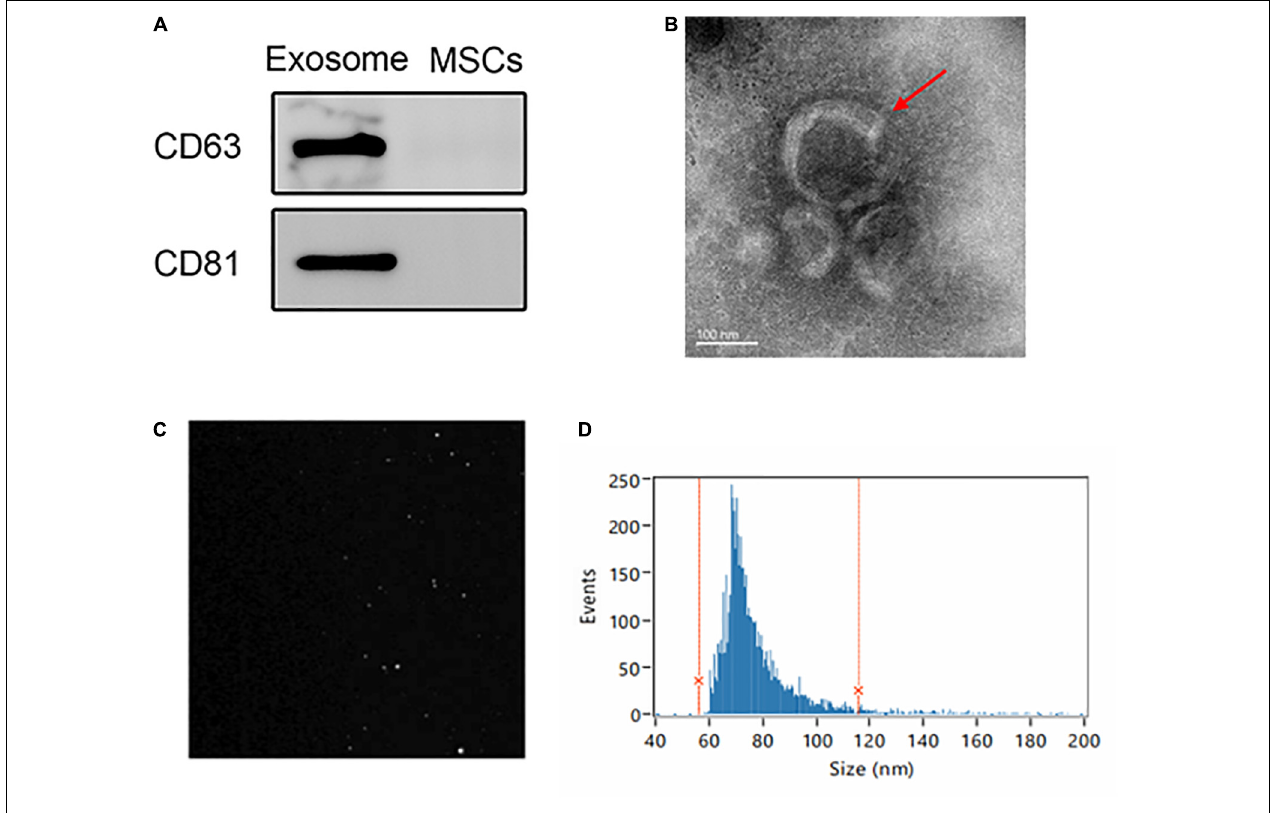
FIGURE 2 | Extraction and identification of UC-MSC-Exo. (A) Expression of exosome markers (CD63 and CD81) examined by western blot analysis. (B) Representative images showing the morphology of UC-MSC-Exo by transmission electron microscopy. Scale bar = 100 nm. (C) The Brownian movement of the UC-MSC-Exo. (D) NTA analysis demonstrating the diameter of exosomes which ranged from 56.07 to 115.71 nm, with a mean diameter of 75.66